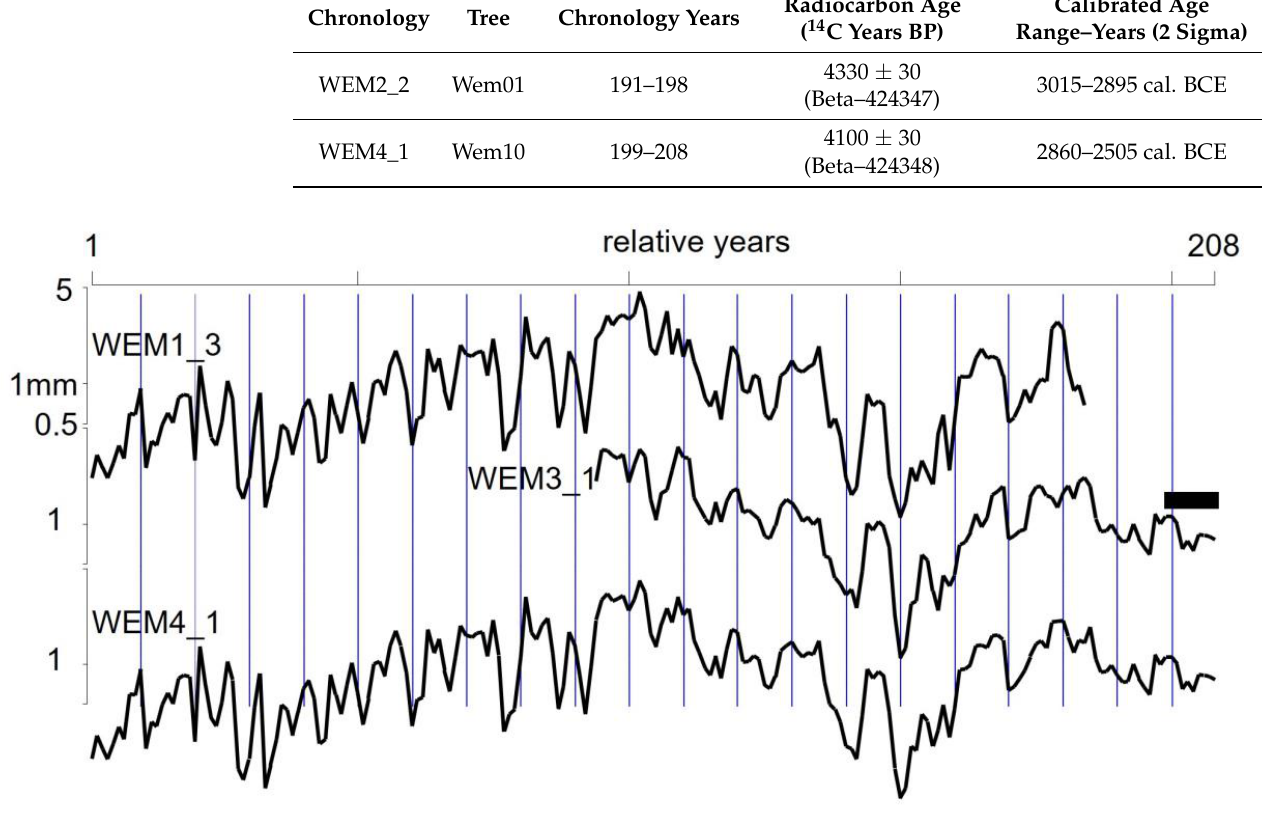
Figure 6. Ring-width records of interim site chronologies WEM1_3 (4 ring-width records) and WEM3_1 (2 records) and the resultant 208-year site chronology Wem4_1 (6 records), illustrating the chronology building process. Black rectangle highlights wood sent for 14 C assay (Wem10, individual sample component of chronology WEM3_1, rings 198 – 208).